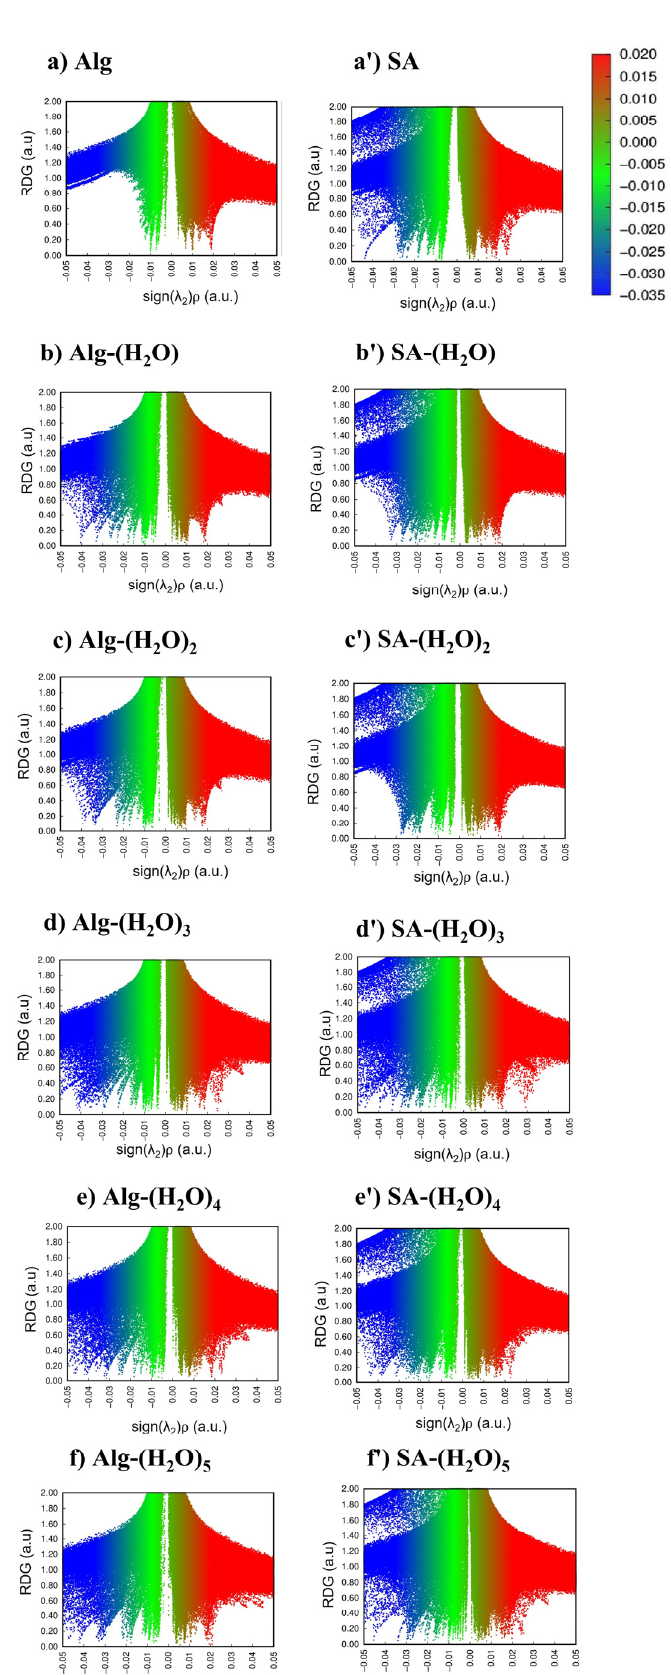
Figure 2. Scatter graph of RDGs for alg ( a ), alg-(H 2 O) n complexes ( b – f ), SA ( a (cid:48) ), and SA-H 2 O complexes ( b (cid:48) – f (cid:48)